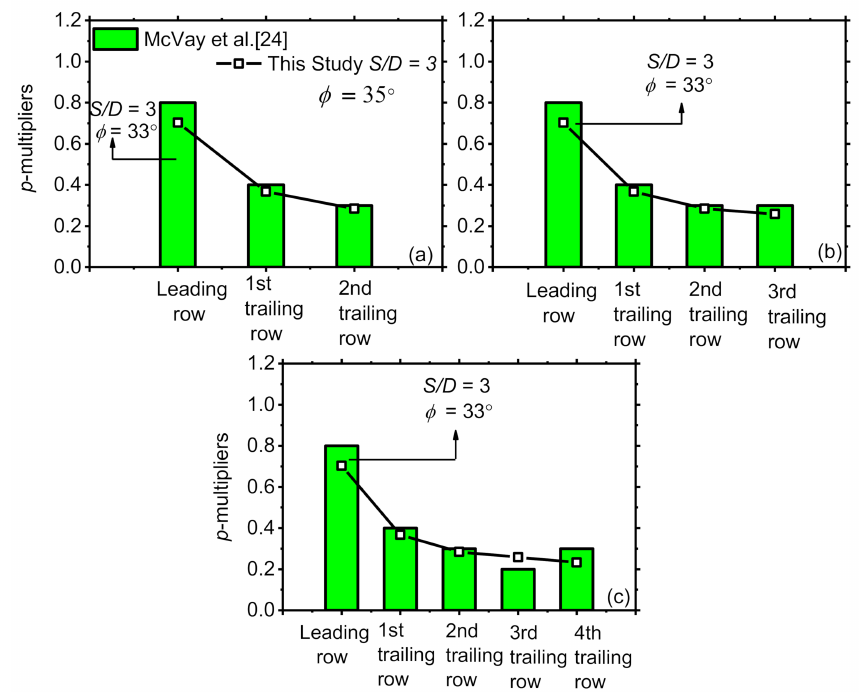
Figure 9. Comparison of fixed-head pile groups in sands calculated in this study and measured from centrifuge tests with ( a ) 3 × 3, ( b ) 3 × 4, and ( c ) 3 × 5 pile configurations performed by McVay et al.